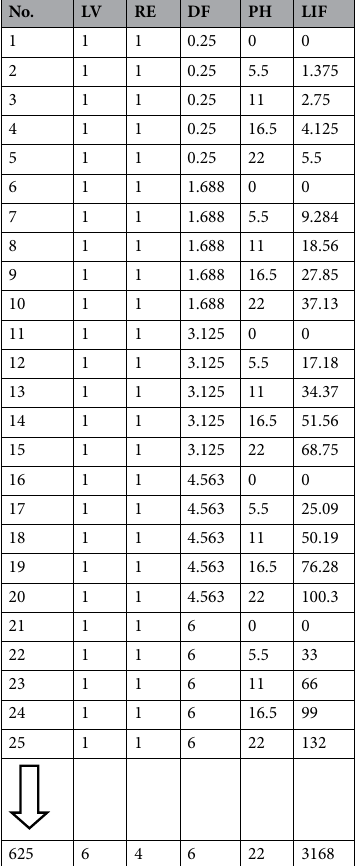
Table 2. Statical description on data set of LIF model.